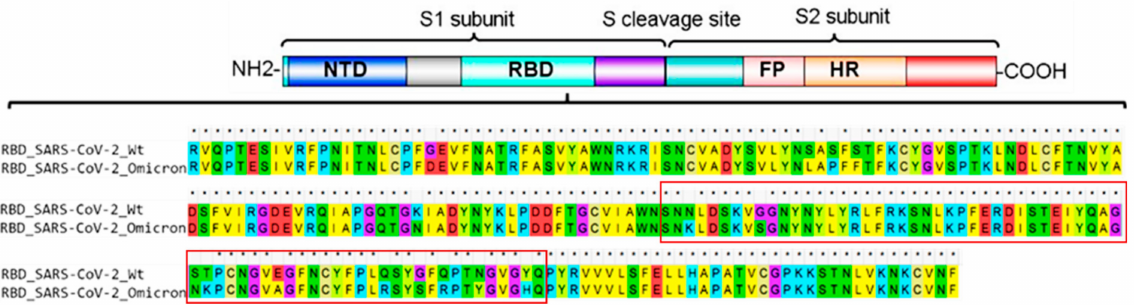
Figure 1. The coronavirus spike protein domain architecture and sequence alignment of the original RBD of SARS-CoV-2 and the RBD of the Omicron variant. Asterisks denote identical amino acid residues. The red rectangular box indicates the receptor-binding motif of RBD. NTD, N-terminal domain; RBD, receptor-binding domain; FP, fusion peptide; HR, heptad